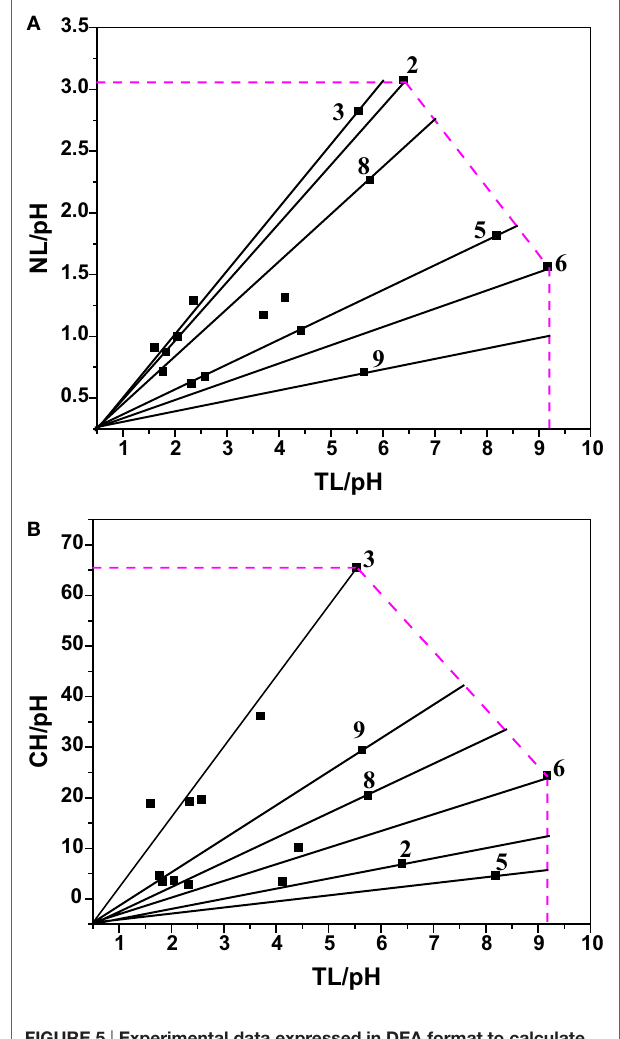
FigUre 5 | experimental data expressed in Dea format to calculate the relative efficiency [(a) neutral lipids (nl) rate and Total lipids (Tl) vis a vis ph; (B) carbohydrate (ch) and Total lipid (Tl) vis a vis ph]